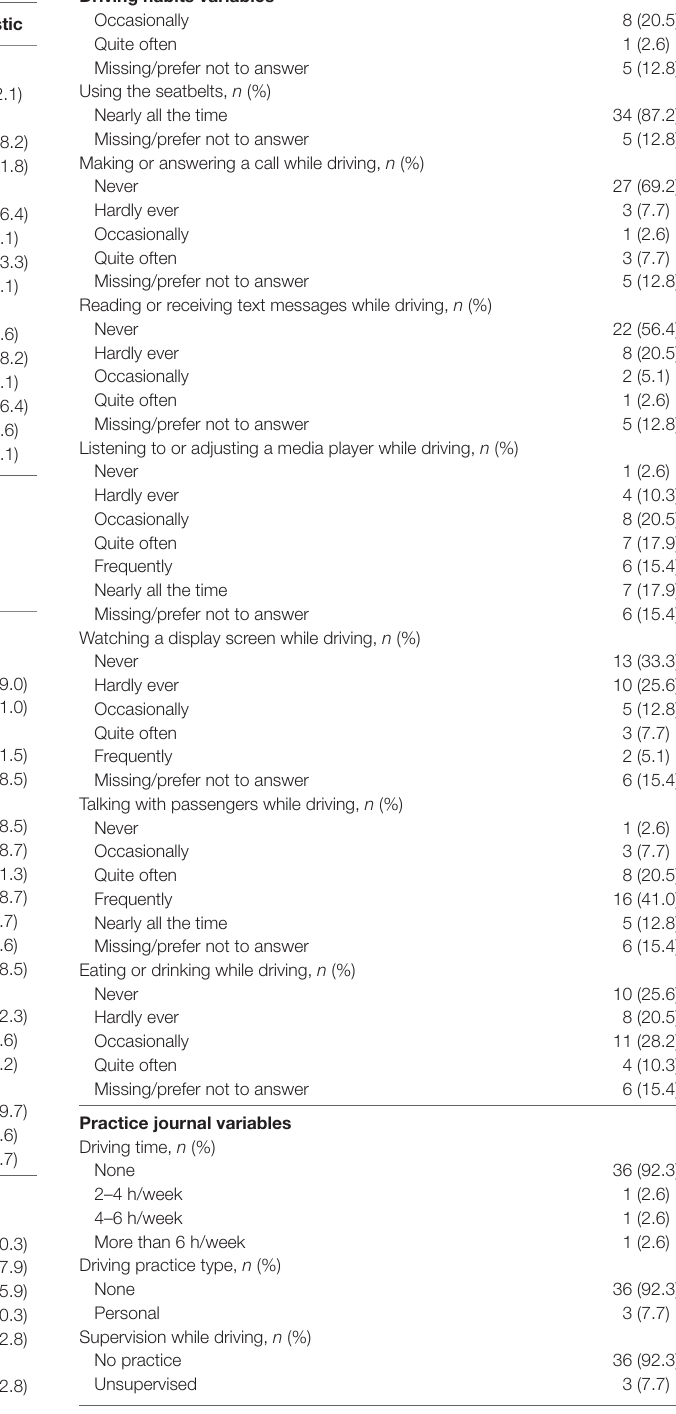
Table 1 | Descriptive statistics for demographic, driving history, and practice journal variables ( n =